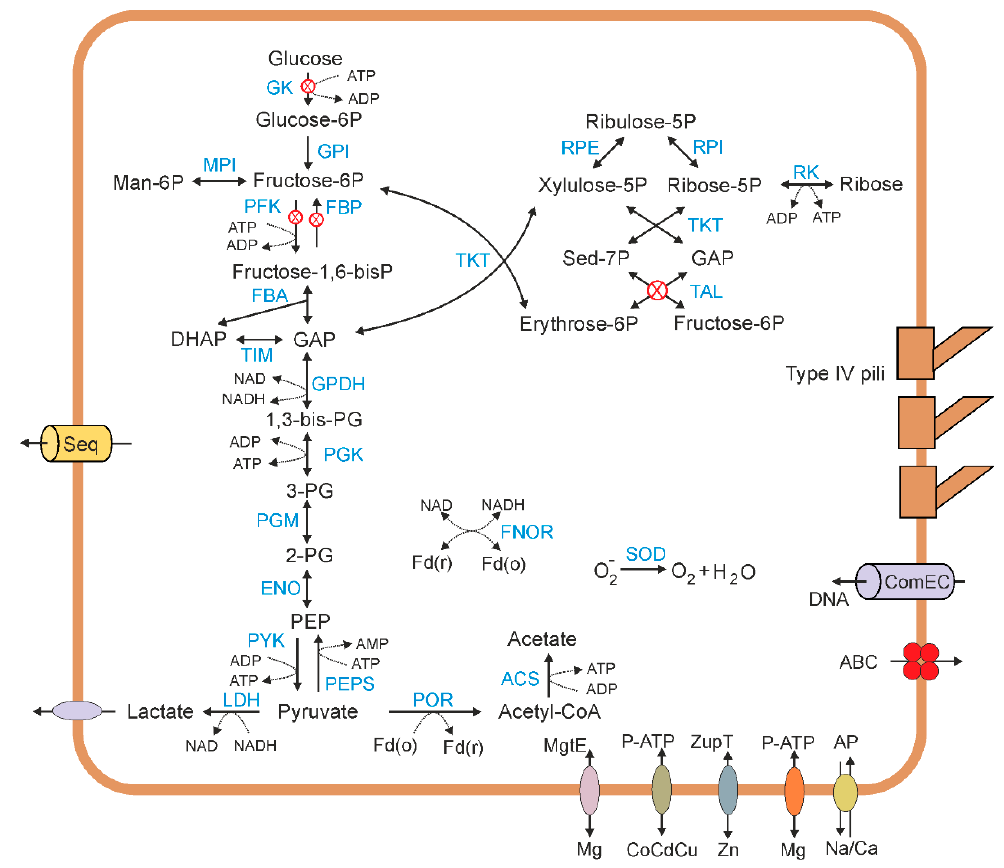
Figure 5. Overview of the metabolism of Ch65 bacterium. Abbreviations: GK, glukokinase; GPI, glucose ‐ 6 ‐ phosphate isomerase; MPI, mannose ‐ 6 ‐ phosphate isomerase; PFK, 6 ‐ phosphofructokinase; FBP, fructose ‐ 1,6 ‐ bisphosphatase; FBA, fructose ‐ bisphosphate aldolase; TIM, triosephosphate isomerase; GPDH, glyceraldehyde 3 ‐ phosphate dehydrogenase; PGK, phosphoglycerate kinase; PGM, phosphoglycerate mutase; ENO, enolase; PK, pyruvate kinase; PEPS, phosphoenolpyruvate synthase; LDH, lactate dehydrogenase; POR, pyruvate ferredoxin oxidoreductase; ACS, acetyl ‐ CoA synthetase; RPE, ribulose ‐ phosphate 3 ‐ epimerase; RPI, ribose 5 ‐ phosphate isomerase; RK, ribokinase; TKT, transketolase; TAL, transaldolase; FNOR, ferredoxin ‐ NADP(+) reductase; SOD, superoxide dismutase; ABC, ABC ‐ type transporter; P ‐ ATP, P ‐ type ATPase; AP, antiporter; Man ‐ 6P, mannose ‐ 6 ‐ phosphate; Sed ‐ 7P, sedoheptulose ‐ 7 ‐ phosphate; GAP, glycerinaldehyde ‐ 3 ‐ phosphate; DHAP, dihydroxyacetone phosphate; 1,3 ‐ bis ‐ PG, 1,3 ‐ biphosphoglycerate; 3 ‐ PG, 3 ‐ phosphoglycerate; 2 ‐ PG, 2 ‐ phsophoglycerate; PEP, phosphoenolpyruvate; Fd(o) and Fd(r), oxidized and reduced forms of ferredoxin. Red signs indicate missing genes from the respective pathways.